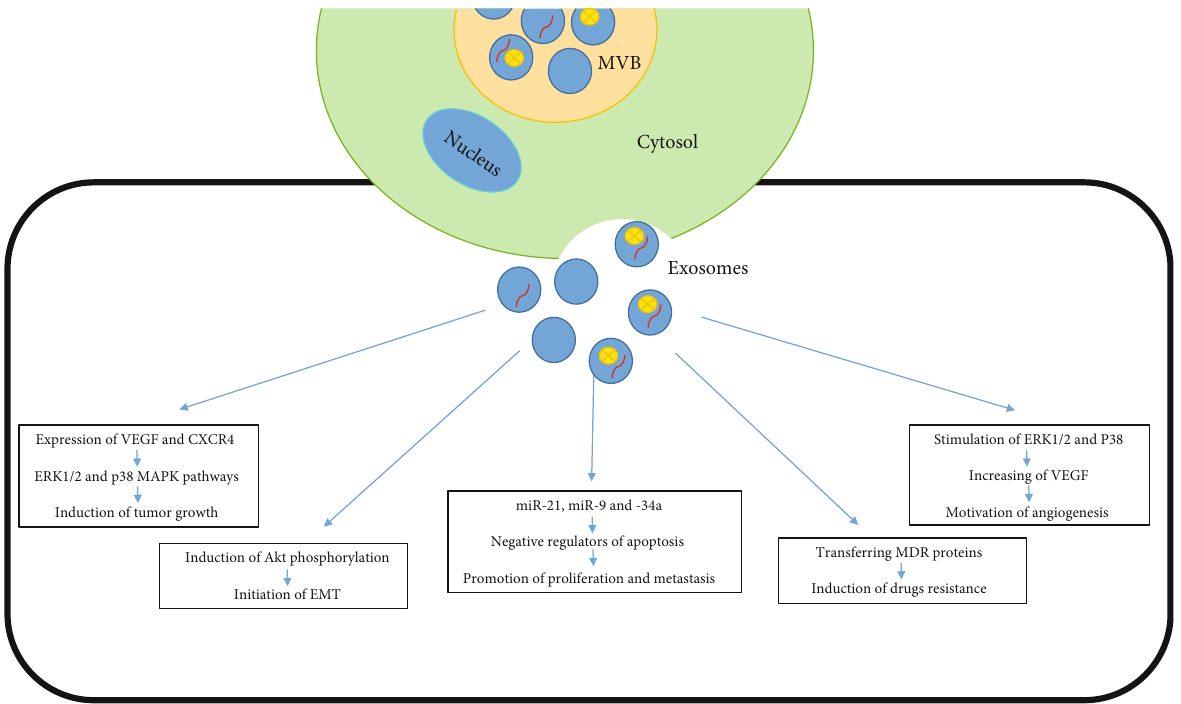
Figure 2: An overview of exosome functions. MSC-EXOs and tumor-derived exosomes exert various e ff ects on recipient cell through di ff erent target/pathway. The interaction between exosome and other cells of TME may result in proliferation, tumor growth, metastasis, and drug resistance. Arrow in the fi gure above: stimulator. MSC-EXOs: MSC ’ s exosomes; TME: tumor microenvironment; VEGF: vascular endothelial growth factor; CXCR4: C-X-C chemokine receptor type 4; ERK1/2: extracellular signal-regulated kinases 1/2; MAPK: mitogen-activated protein kinases; AKT: protein kinase B; EMT: epithelial – mesenchymal transition; mir: microRNA; MDR: multidrug resistance